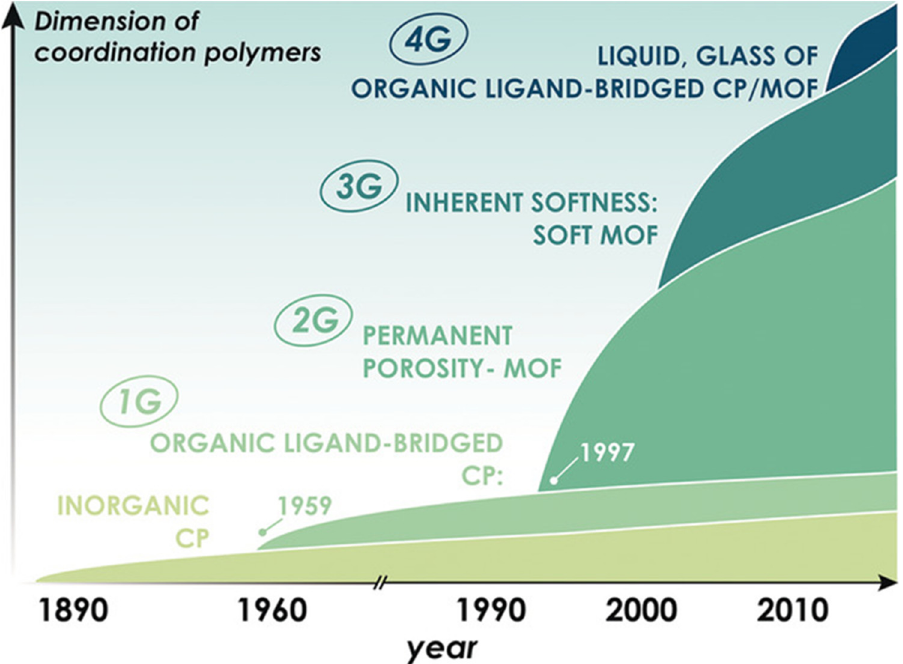
Figure 4. MOF advancement divided into four levels (four generations). Gas science and technology have immensely benefitted from permanent porosity-based MOFs (2nd generation). Current research on MOF development are focused on third and fourth generation MOFs (soft crystals and flexible MOFs) and fourth generation MOFs (glassy MOFs derived from crystalline states) [41] (reprinted from [41] with permission from © 2019 Wiley ‐ VCH Verlag GmbH & Co. KGaA, Weinheim). Current second generation MOFs are attractive 3D porous materials for gas storage and for the separation of some necessary gases such as CH 4 or CO 2 [42,43] due to their material ‐ related properties, such as high specific area, high porosity, structural chemistry and tunable surface functionalization [44–46]. Primarily, MOFs are used for gas storage and gas separation under high or low ‐ pressure conditions at elevated temperatures or ay room temperature. Under such conditions, MOFs are expected to have storage and sepa ‐ ration functions through the physical adsorption and utilization of the pore surface. How ‐ ever, not all pore spaces are fully utilized [43]. However, the application of MOFs in the gas hydrate technology platform requires high pressure, low temperatures (less than 6 °C) and the presence of water. MOF materials are extensively studied with physisorption in the dry state, but in the presence of water, the mechanism for storing gas in the form of gas hydrates could be drastically different from what is initially expected. Furthermore, the gas hydrate phase diagram is also affected in nanoporous materials [47]. This intro ‐ duces additional complexity and challenges that need to be further investigated. 3.2. MOF–Hydrate Potential Synergy Recently, there has been discussion of potential synergies between nanomaterials and hydrates, which are complementary and offer potential synergies in gas storage and separation technologies [19–21]. The synergy between the two technologies stems from the fact that porous nanomaterials (metal–organic frameworks) offer a large surface area, pore volume and tunable chemistry. An increased surface area can increase the gas–liquid contact area, improve the conversion of water to hydrates and shorten the induction time, so this likely plays a role in improved hydrate formation. Another reason for looking for synergies is the idea of lower energy consumption. It is expected that a new process com ‐ bining gas adsorption processes (based on MOFs) and crystallization energy (based on gas hydrates) can reduce overall energy consumption compared with the adsorption ‐ only process (see the Figure 5).